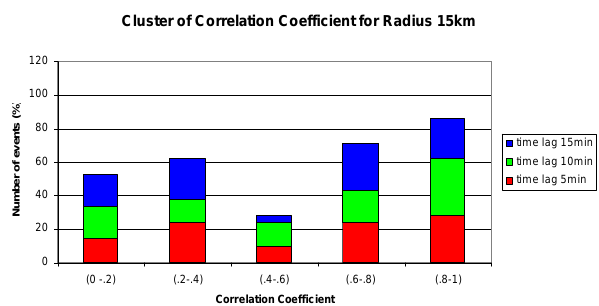
Fig. 7. The percentage of the events per time lag and for a radius of 15km.